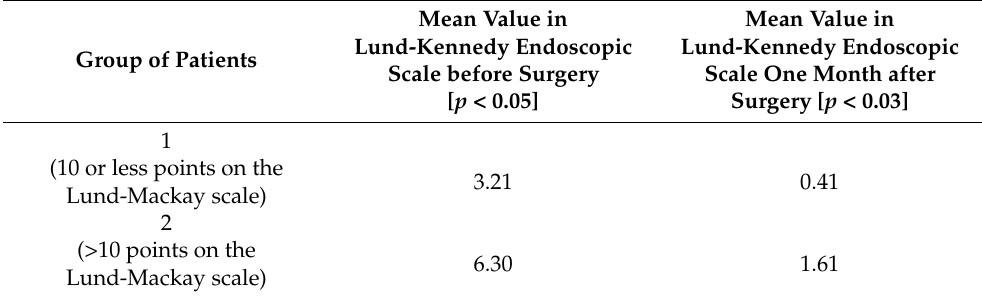
Table 3. Mean value in Lund-Kennedy endoscopic scale before and one month after surgery in group 1 and